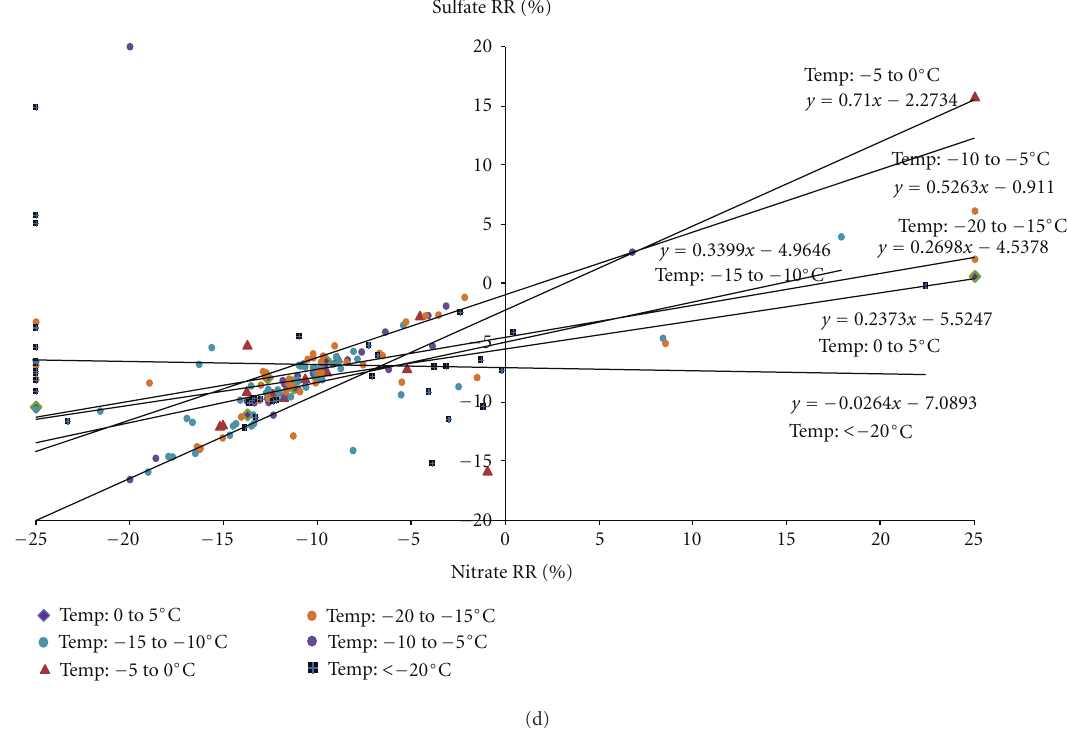
Figure 7: Relative responses of (a) total PM 2 . 5 , (b) sulfate and (c) nitrate concentrations to the assumed fuel sulfur content reductions and (d) relation of relative responses of sulfate and nitrate at di ff erent temperature ranges. The temperature ranges on each bar are the ranges of temperature which has the most frequent occurrence, and the y axis indicates that frequency.